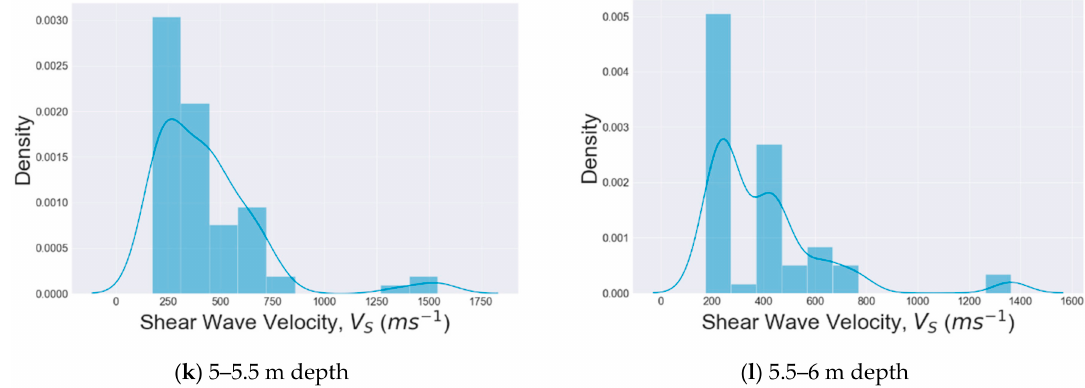
Figure 12. Histograms of the shear wave velocity for each